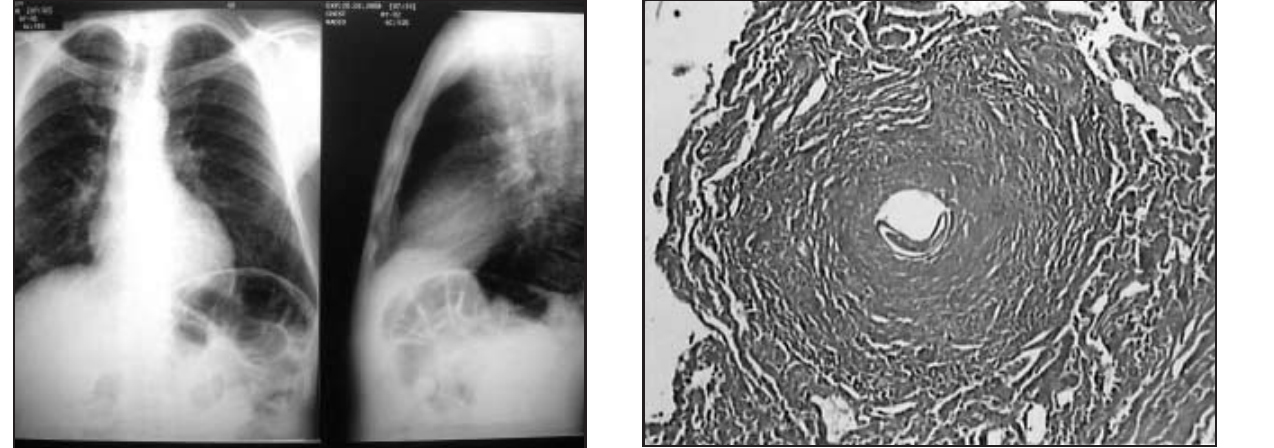
Figura 3 – Fotomicroscopia evidenciando reação granulomatosa não-necrotizante centrada por fungo (adiaconídio) no tecido pulmonar (HE,